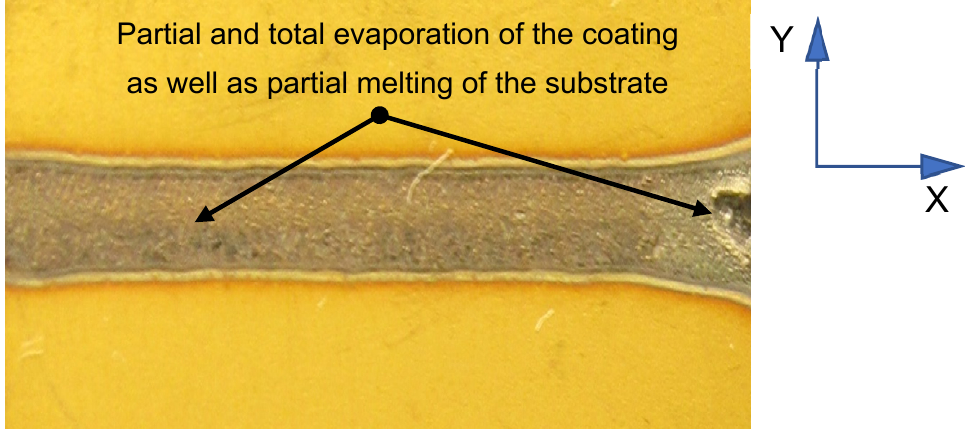
Figure 5. Partial and total evaporation of the coating, as well as partial melting of the substrate, observed after laser heating conducted with a laser beam power density of 12,420 W/cm 2 (60% of the maximum laser power).